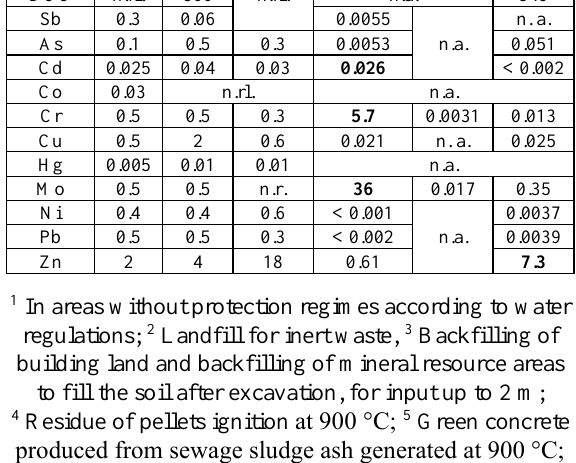
Table 16. Comparison of pH and heavy metal content (in mgkg -1